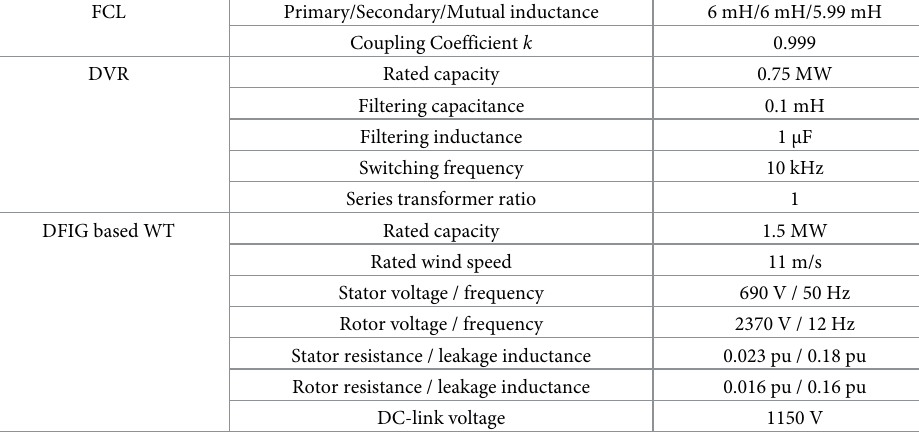
Table 1. Main parameters of the DFIG with the combined